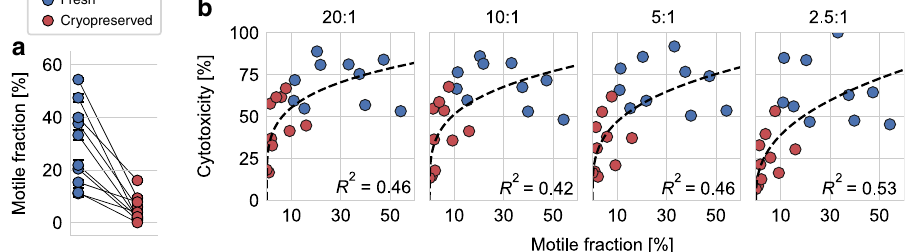
Fig. 3 In fl uence of 3-D NK cell motility on cytotoxicity. a Motile fraction of fresh (blue) and cryopreserved (red) NK cells from n = 10 independent experiments from fi ve subjects and fi ve different expansions in 1.2 mg/ml collagen gel ( p = 0.002; two-sided nonparametric Wilcoxon signed-rank test for paired data). Each symbol represents mean ± se from cells measured in fi ve fi eld of view, with ~80 cells (motile plus nonmotile) in each fi eld of view. In total, n = 1248 fresh motile cells and n = 122 cryopreserved motile NK cells were measured. Paired (fresh vs. cryopreserved) data from each subject and expansion are connected by lines. b NK cell cytotoxicity (as measured in a chromium-release assay) as a function of the motile NK cell fraction for fresh (blue) and cryopreserved (red) NK cells. Different NK-to-target cell ratios are noted above each graph. Dashed lines indicate a power-law fi t of the form f ( x ) = a · x b . R 2 values are computed in log – log space. Statistical signi fi cance assuming a power-law exponent of b = 0 as null hypothesis: 20:1: p = 0.0013; 10:1: p = 0.0028; 5:1: p = 0.0013; 2.5:1: p = 0.00045 by two-sided nonparametric Wilcoxon signed-rank test for paired data. Source data are provided as a Source data fi